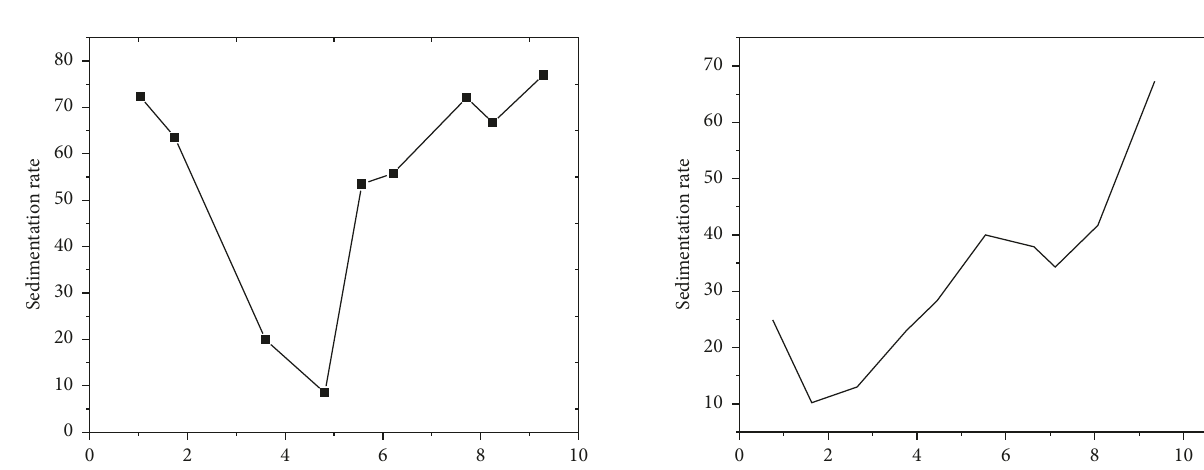
Figure 2: The relationship between the percentage of mass used in silane coupling agent KH-570 and the sedimentation